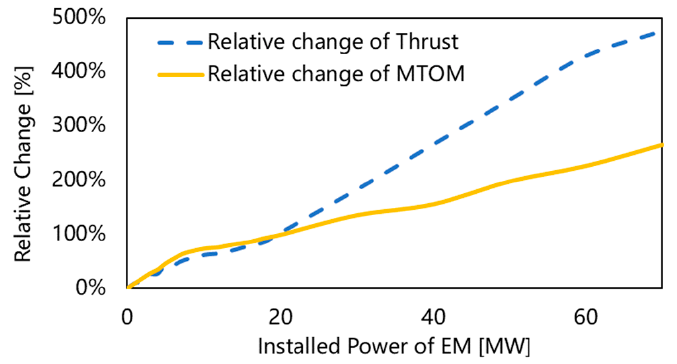
Figure 10. Comparison of the relative change of thrust and MTOM.